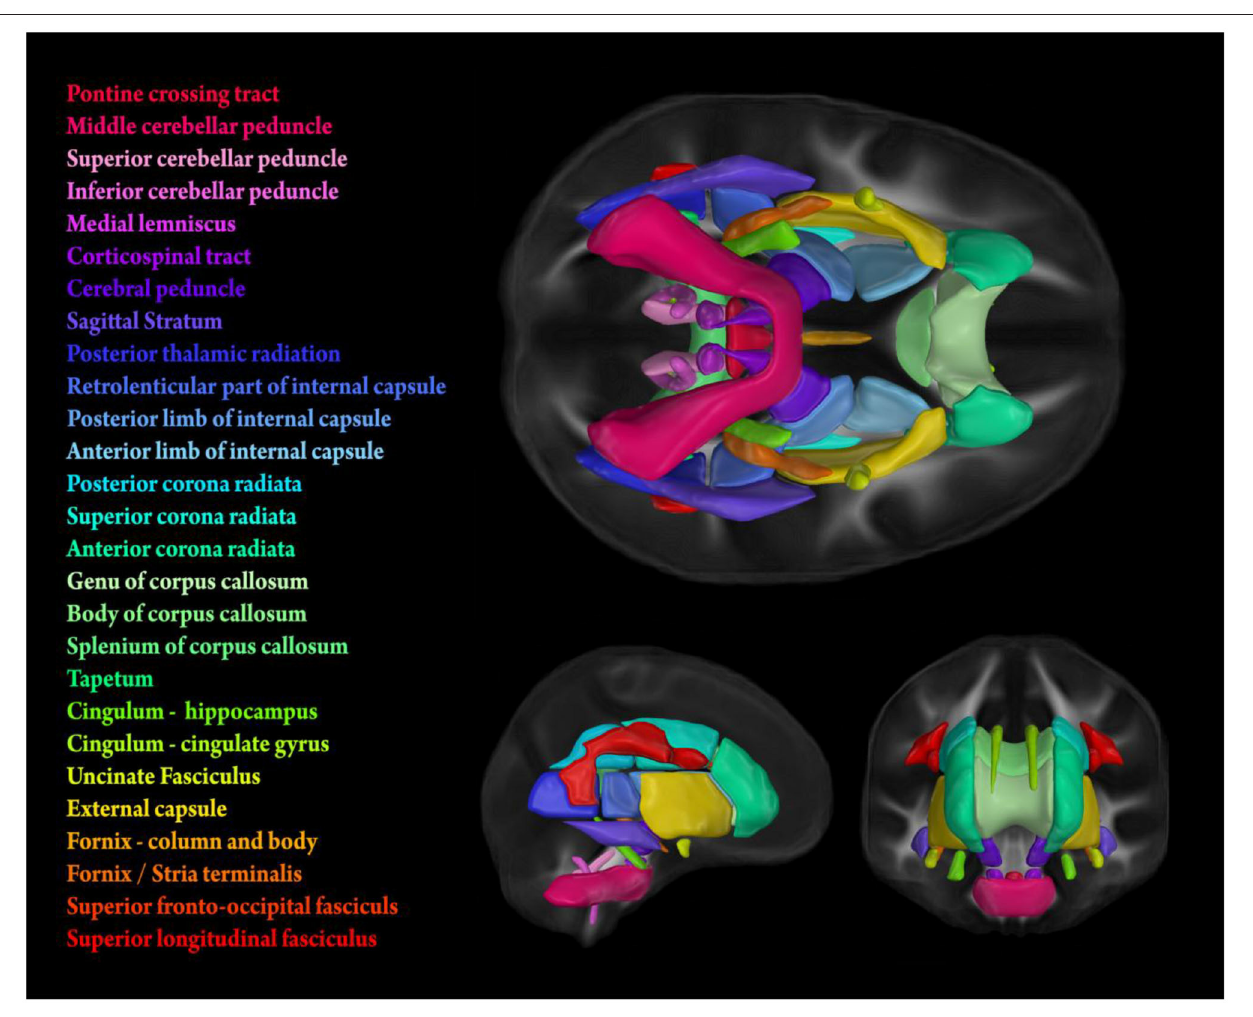
FIGURE 1 | Stylized depiction of 21 bilateral and 6 midline tracts from the Johns Hopkins University (JHU) white matter parcellation atlas (Mori et al., 2005). FA values used for analyses were obtained by calculating tract-wise means from the intersection of the atlas and the individual FA skeletons generated using TBSS (see subsection MRI Data Acquisition and Processing for